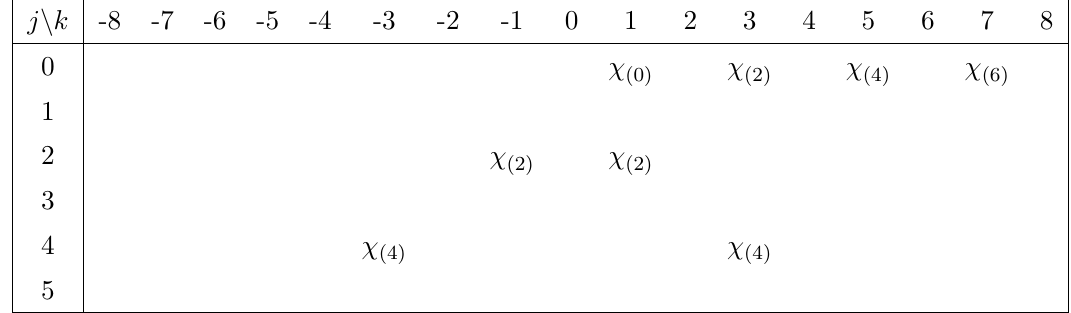
Table 10. Nonvanishing coe(cid:14)cients a (3) terms of the Sp(1) characters (cid:31)